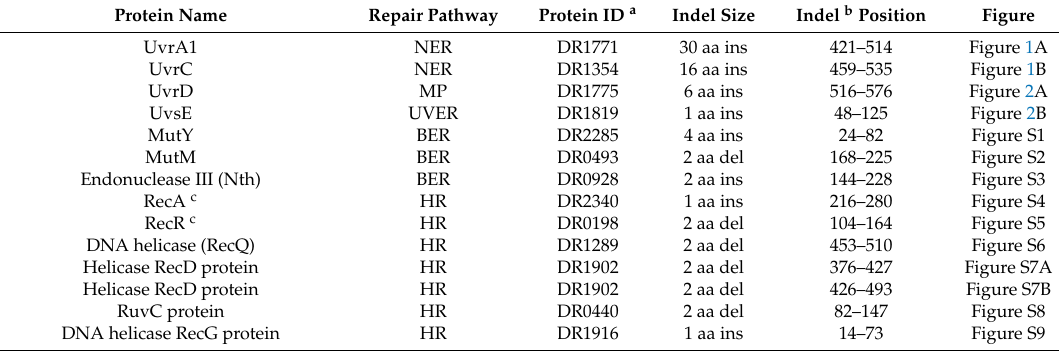
Table 1. Summary of the Deinococcus -specific Conserved Signature Indels (CSIs) in DNA Repair